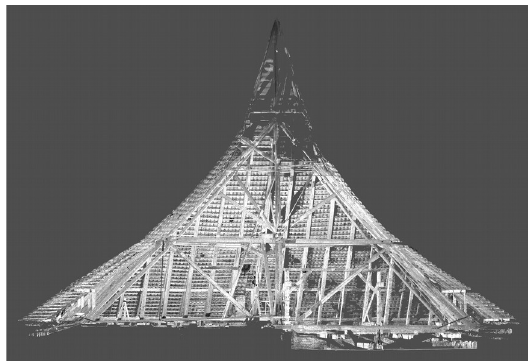
Figure 3. Section of the pagoda roof that shows the inner part of the structure.